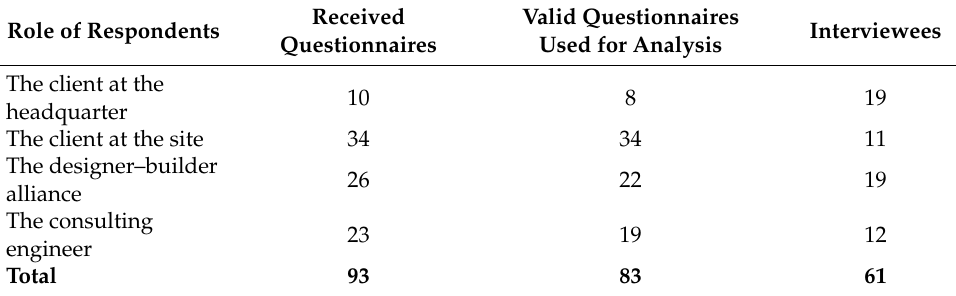
Table 1. The distribution of questionnaires and